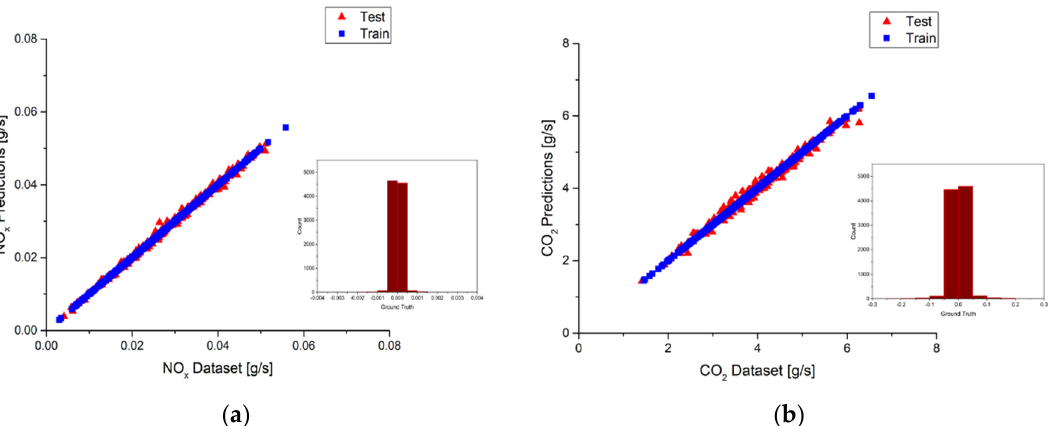
Figure 21. ( a ) Deviations between the predictions and the measurements and ground truth plot of the best NO x model in